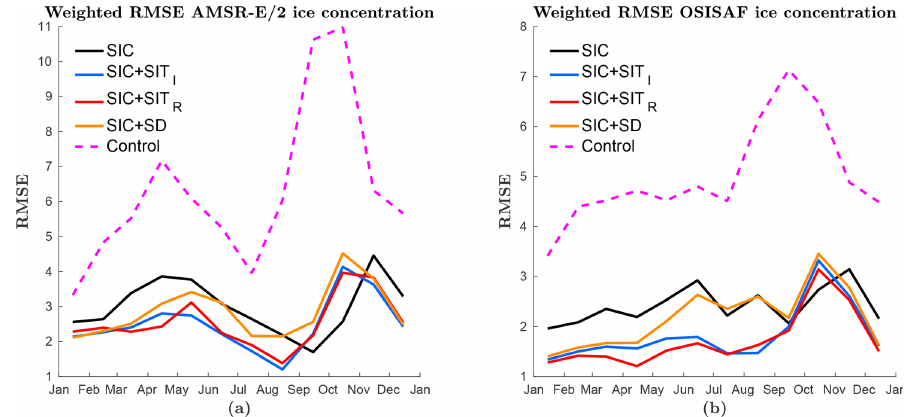
Figure 2. The monthly averaged RMSE of the ensemble mean SIC over 3 years. In (a) the model is validated against AMSR-E/2 SIC observations and (b) OSISAF SIC observations. The lines represent different experiments: black is only SIC assimilation, blue is SIC and CryoSat-2 thick internal SIT assimilation, red is SIC and SMOS and thin rim SIT assimilation, yellow is SIC and snow-depth (SD) assimilation and magenta dotted is without